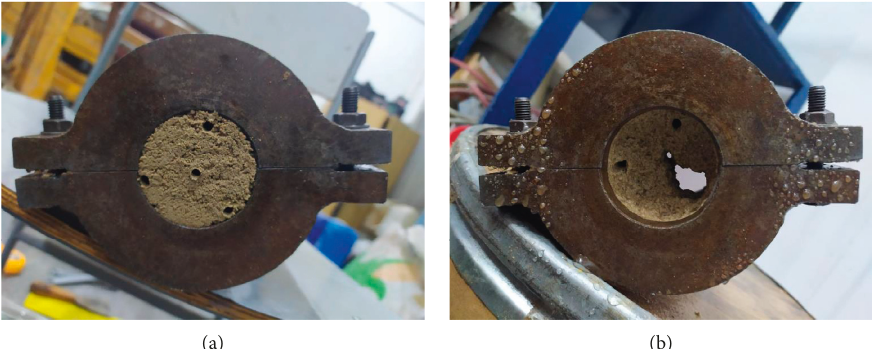
Figure 12: One comparison of the initial cracks and destroyed soil layer: (a) initial cracks of experiment No. 21; (b) cracks broaden lead to soil destruction of experiment No.